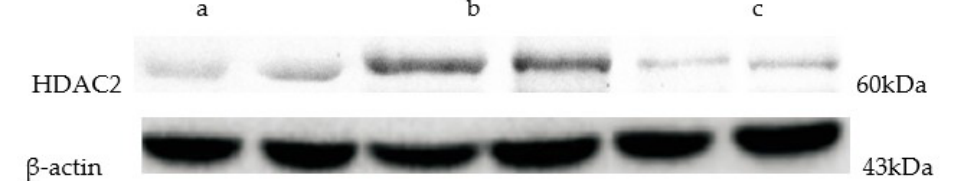
Figure 4. The protein expression of HDAC2 in different groups (( a ) LO2 cells; ( b ) HepG2 cells; ( c ) compound 4 on HepG2 cells).